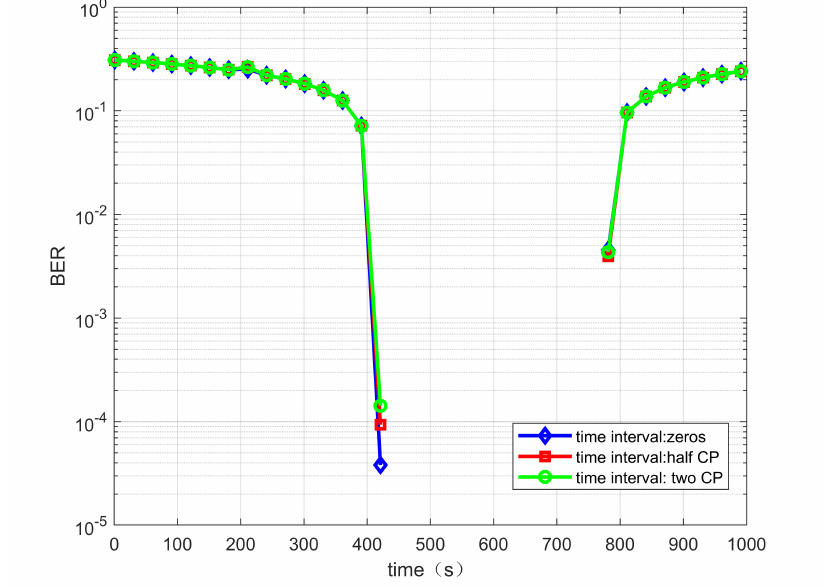
Figure 6. BER performance versus time for the link between satellite 1 and IoT